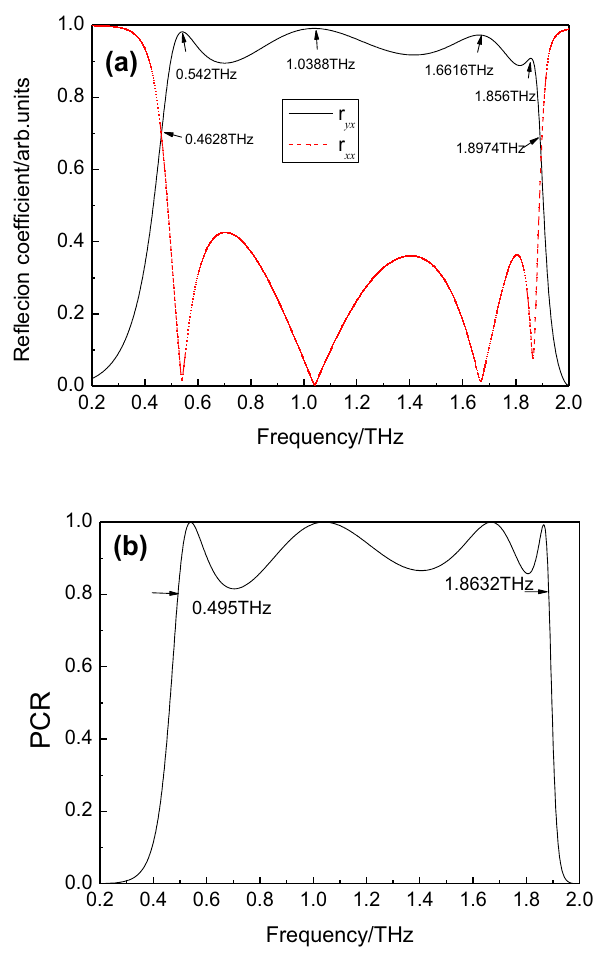
Fig. 2 a Reflectivity curves for cross and synclastic polarization r and r ; b Polarization conversion rate of the polarization converter xx